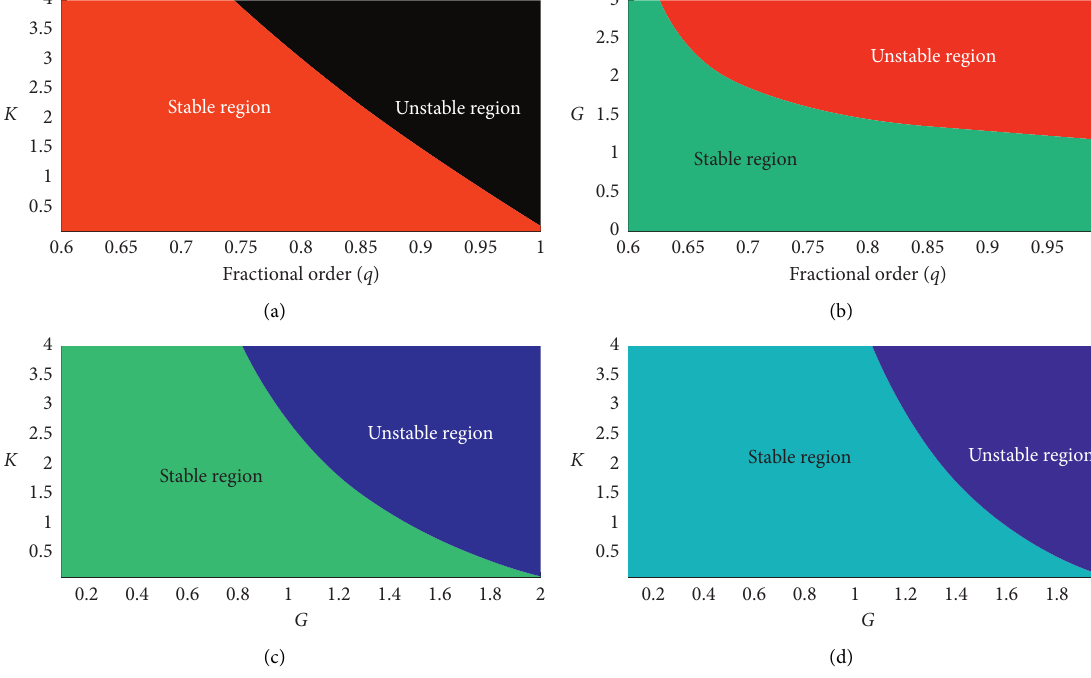
Figure 2: Stability regions of the equilibrium point [0, 0, 0] of the FOPLL system for (a) various fractional orders and parameter K with parameter G � 1; (b) various fractional orders and parameter G with K � 2.5; (c) various values of parameters K and G with fractional orders q � 0.98 and q � 0.9 as shown in (c) and (d).